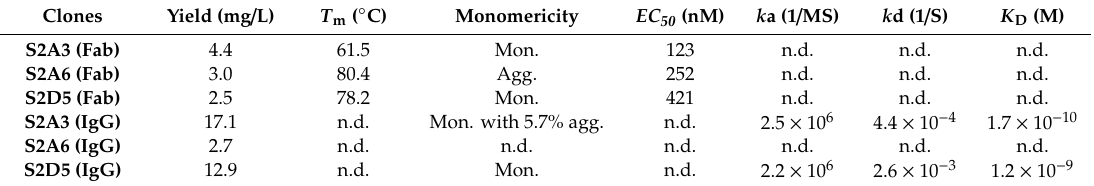
SEC, size-exclusion chromatography; IgG, immunoglobulin G; n.d, not determined; T m , melting temperature; EC 50 , half maximal e ff ective concentration; k a, association rate constant; k d, dissociation rate constant; K D , equilibrium Table 1. Physicochemical properties of human anti-MERS-S2P monoclonal antibodies (mAbs). Yield T m Monomericity EC 50 Clones (nM) (mg/L) (°C) S2A3 (Fab) S2A6 (Fab) S2D5 (Fab) 2.5